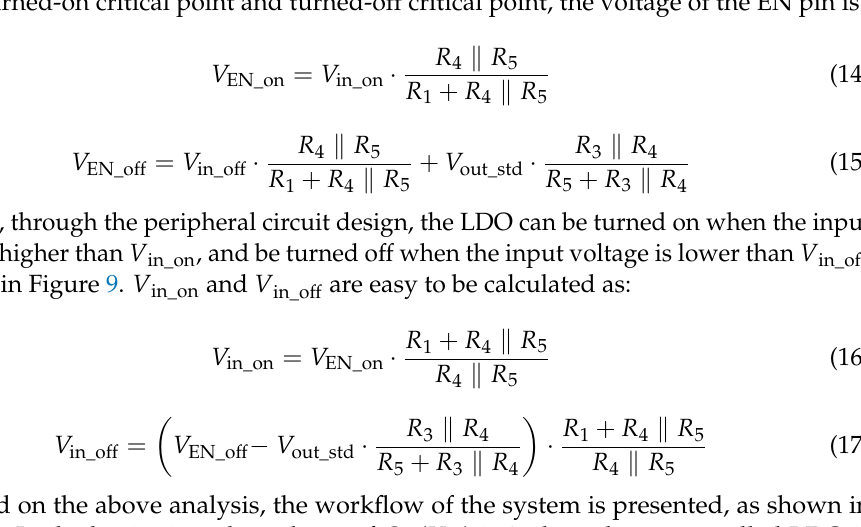
Since the output voltage of LDO is constant in the turned-on state (set as V out_std ), thus, at turned-on critical point and turned-off critical point, the voltage of the EN pin is: